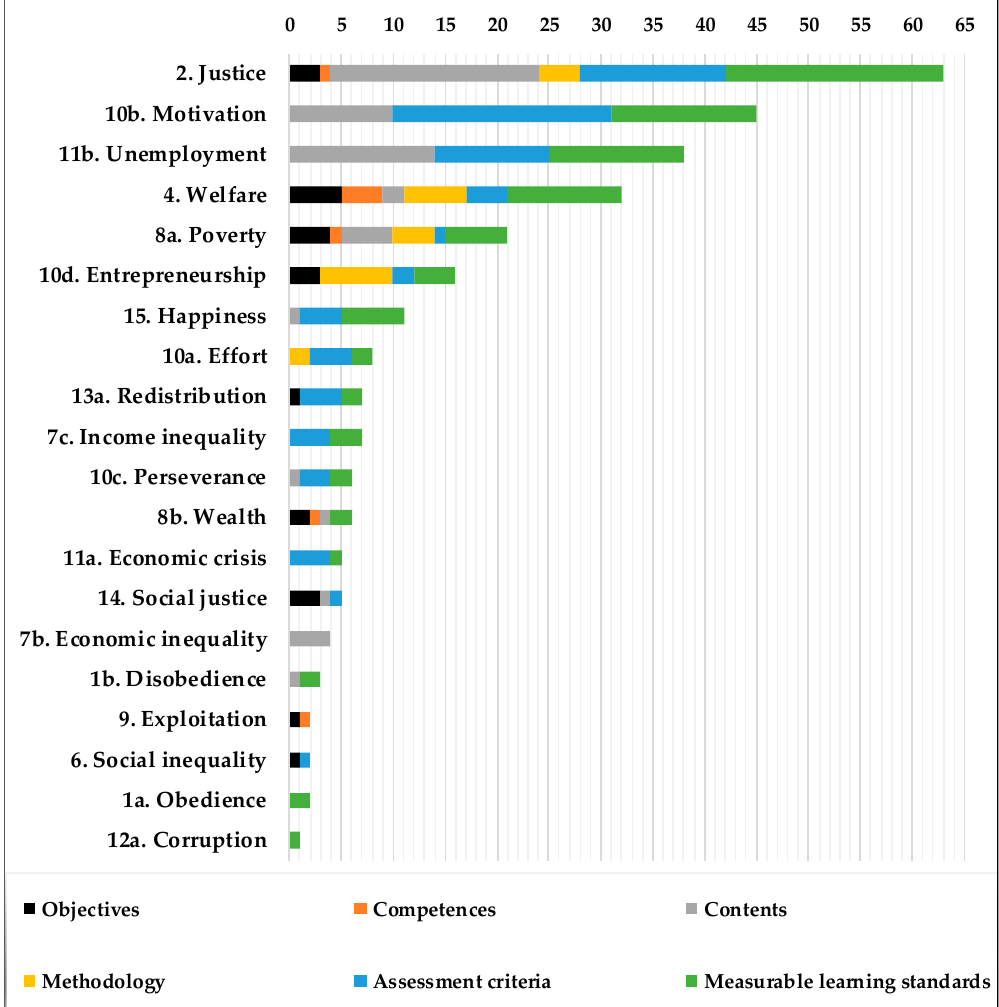
Figure 3. Number of keywords per curricular element.